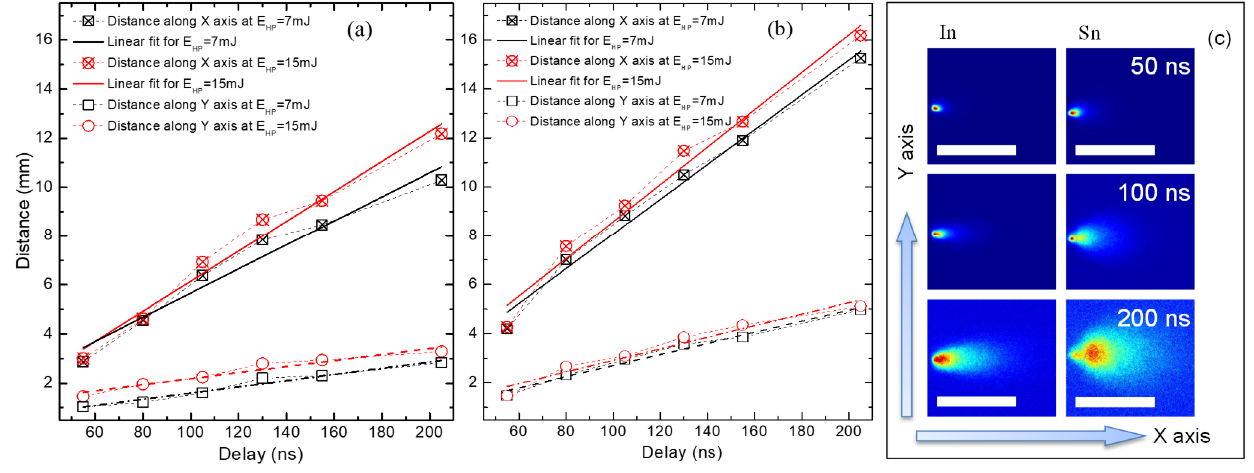
Figure 2. Panels ( a ) (indium LIP) and ( b ) (tin LIP) show the measurements of plasma spreading along the longitudinal X-axis (crossed squares and crossed circles, correspondingly) and along the transverse Y-axis (empty squares and empty circles, correspondingly) at two HP energies (7 mJ, black squares; 15 mJ, red circles). The slopes of the linear fits (black and red solid lines) are used to determine the linear velocity of the emitting front of the plasmas along the X-axis. ( c ) The raw images of plasmas at different delays varying between 50 and 200 ns. White scale bar has length equal to 10 mm.